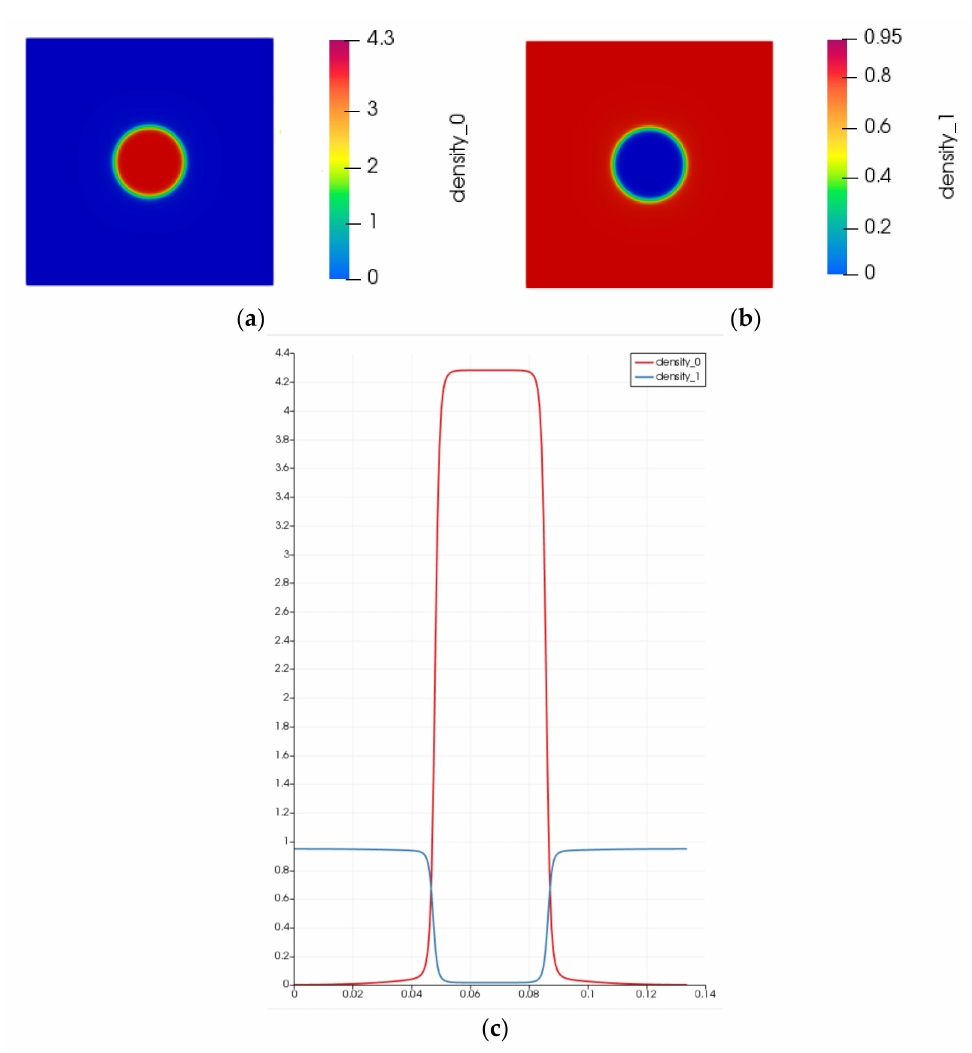
Figure 2. 2-Dimensional static H 2 O droplet at equilibrium surrounded by CO 2 . Contours of the domain with a size of 201 × 201 LU. Density is shown in LU [23]. ( a ) Grid one: H 2 O drop in red surrounded by an empty region in blue. ( b ) Grid two: CO 2 in red surrounding an empty region in blue. ( c ) Density profile at the cross-section of the domain taken at the horizontal centerline (y = 100